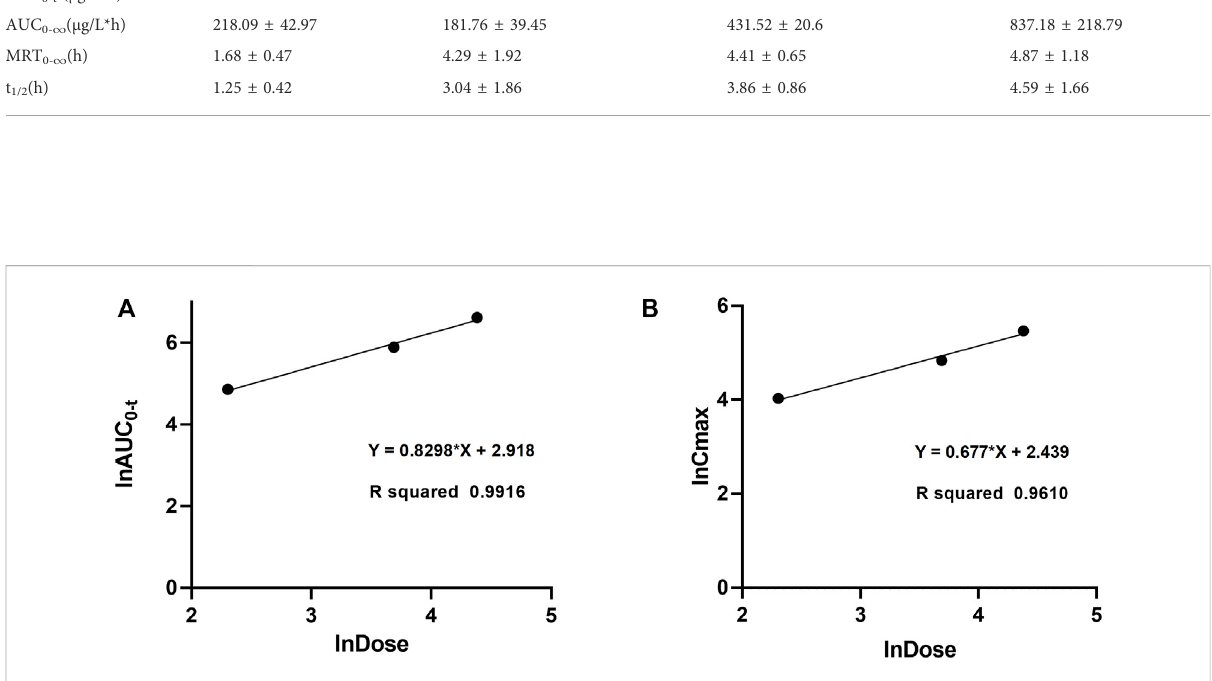
FIGURE 5 Dose proportionality of AUC 0-t (A) and C max (B) for curcumol in rats at doses of 10, 40, and 80 mg/kg after oral administration.